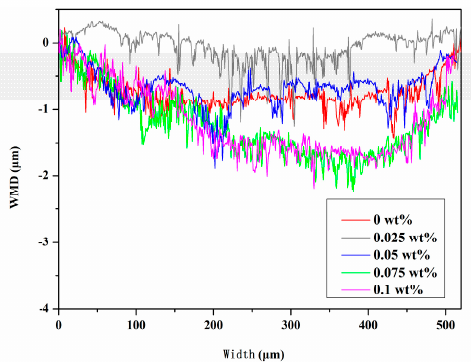
Figure 3. Wear mark depth (WMD) profile curve of the Si 3 N 4 disk lubricated by different FLG contents.